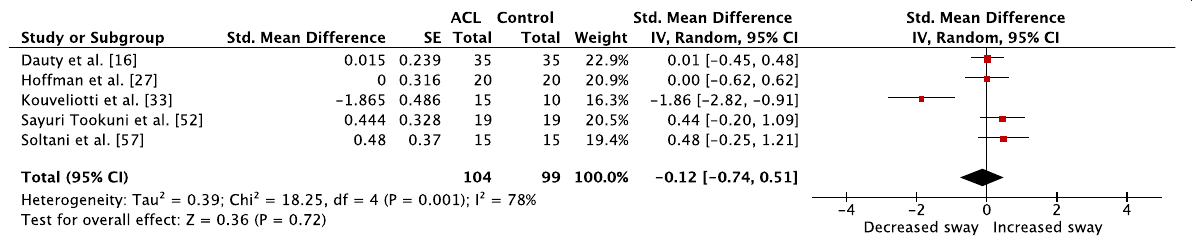
Fig. 6 Forest plot comparison of sway magnitude between the ACL-non-injured and ACL-matched control leg. Std . standardized, SE standard error, IV inverse variance, CI confidence interval, df degrees of freedom, ACL anterior cruciate ligament